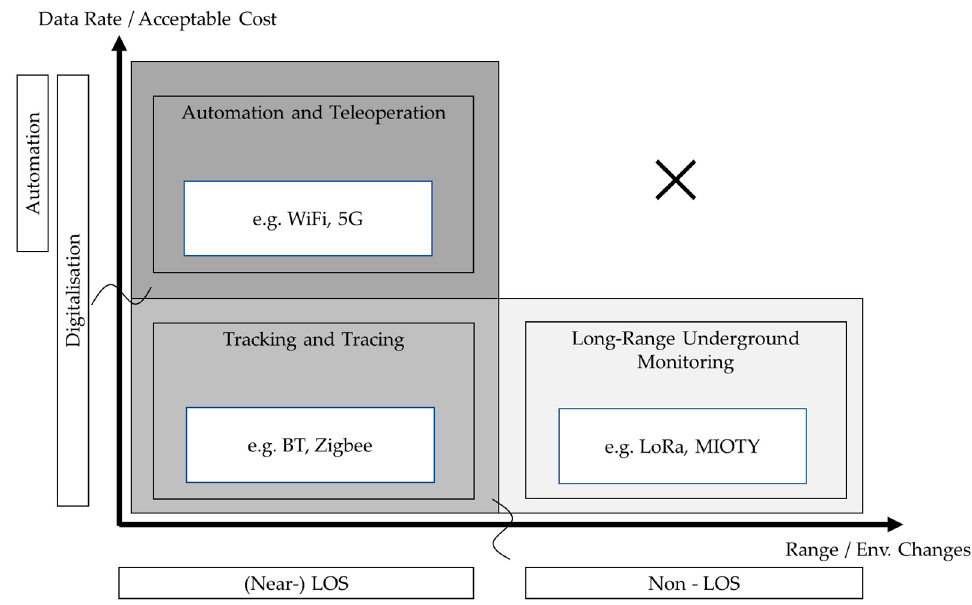
Figure 6. Mapping of basic network properties, use cases and connected technologies.